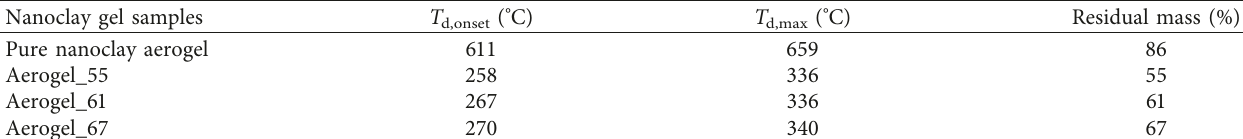
Table 4: TGA results of nanoclay aerogel masterbatches.